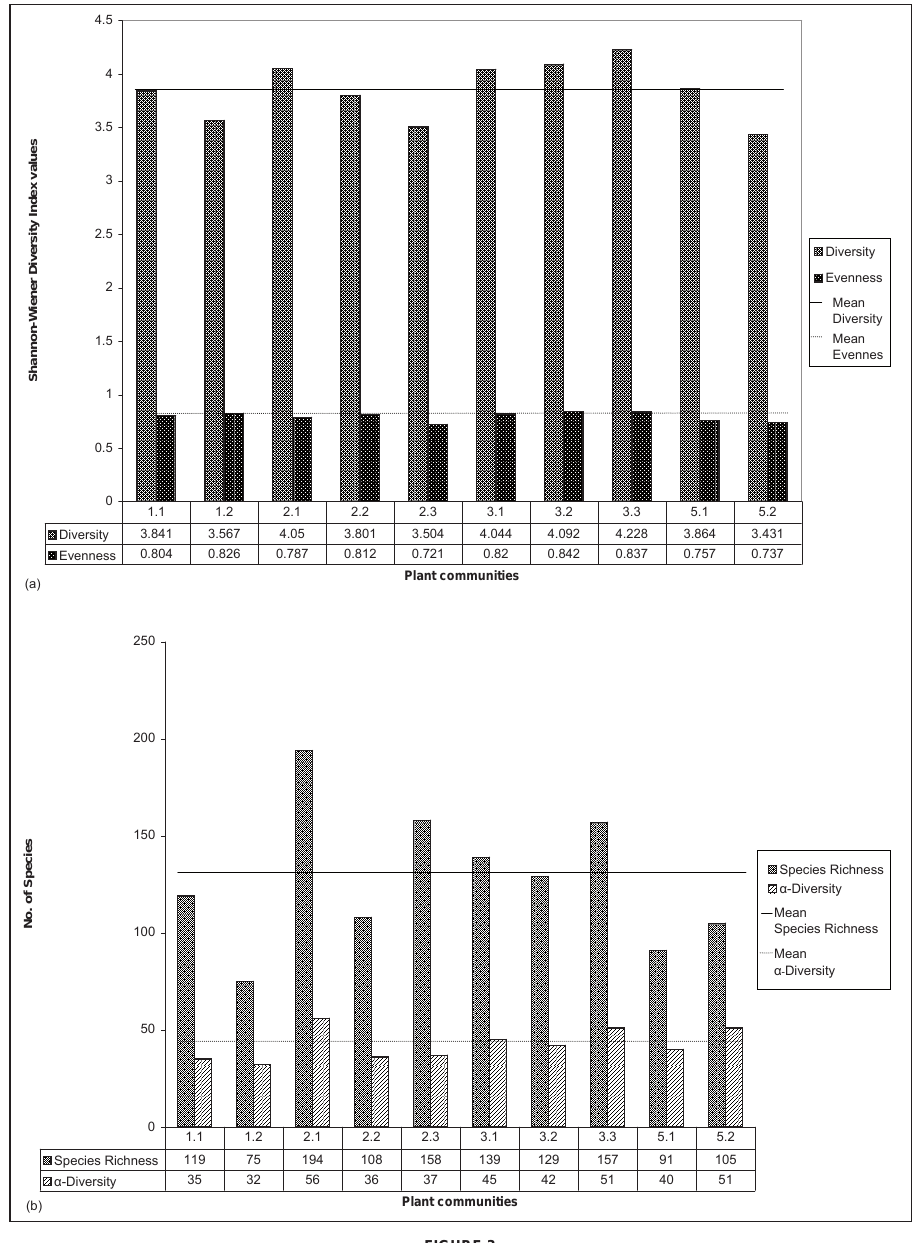
Figure 3 Analysis of species diversity, evenness and richness of all plant sub-communities identified for the Nkhuhlu exclosure site: (a) Shannon-Wiener indices of diversity and evenness, and (b) α-Diversity (mean no. of species per plot) and species richness (mean no. of species per